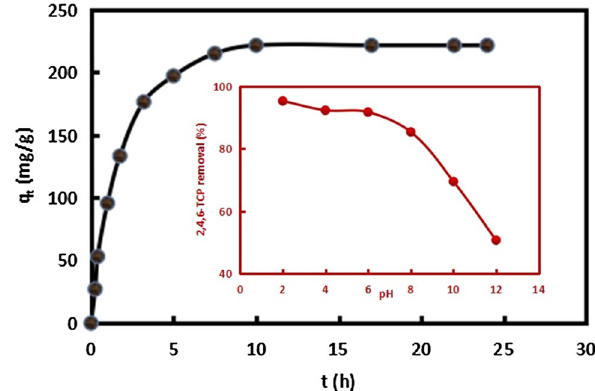
Fig. 8 a Langmuir isotherms, b Freundlich isotherms and c Temkin isotherms of the CSSS-AC for 2,4,6-TCP adsorption at 30